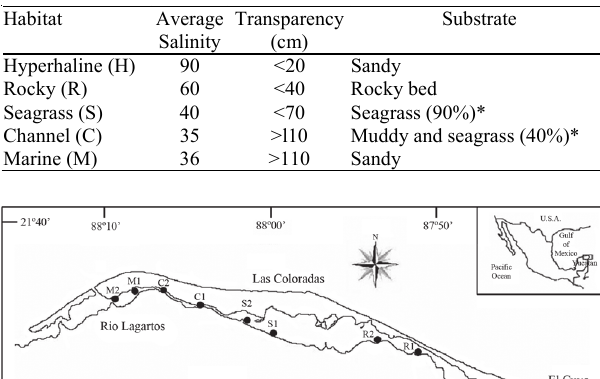
Table 1. Structural and hydrological characteristics of the different habitats proposed in Ría Lagartos Lagoon, Mexico. *Refers the percentage cover in each